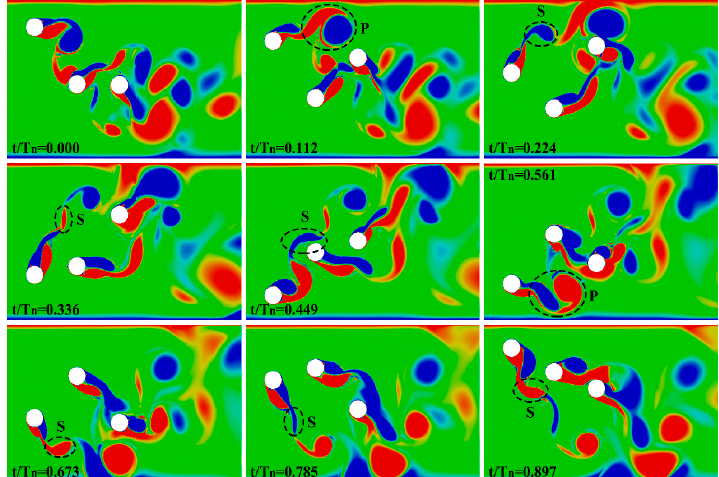
Figure 14. Near-wake structure of the three cylinders when Re = 100,000. Energies 2018 , 11 , x FOR PEER REVIEW